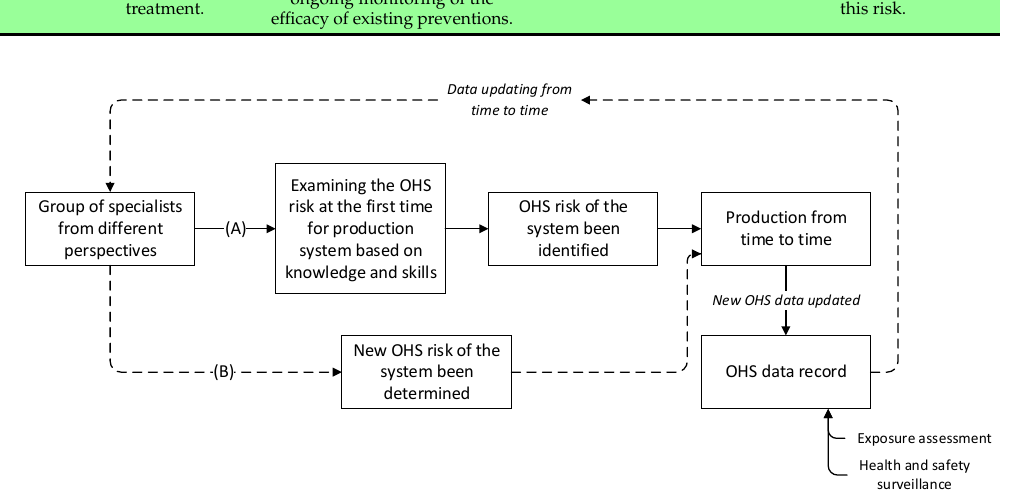
Figure 8. Workflow of the integration method.